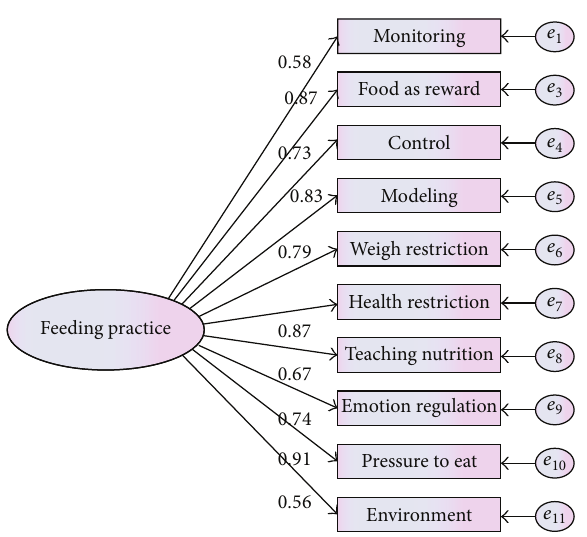
Feeding practice